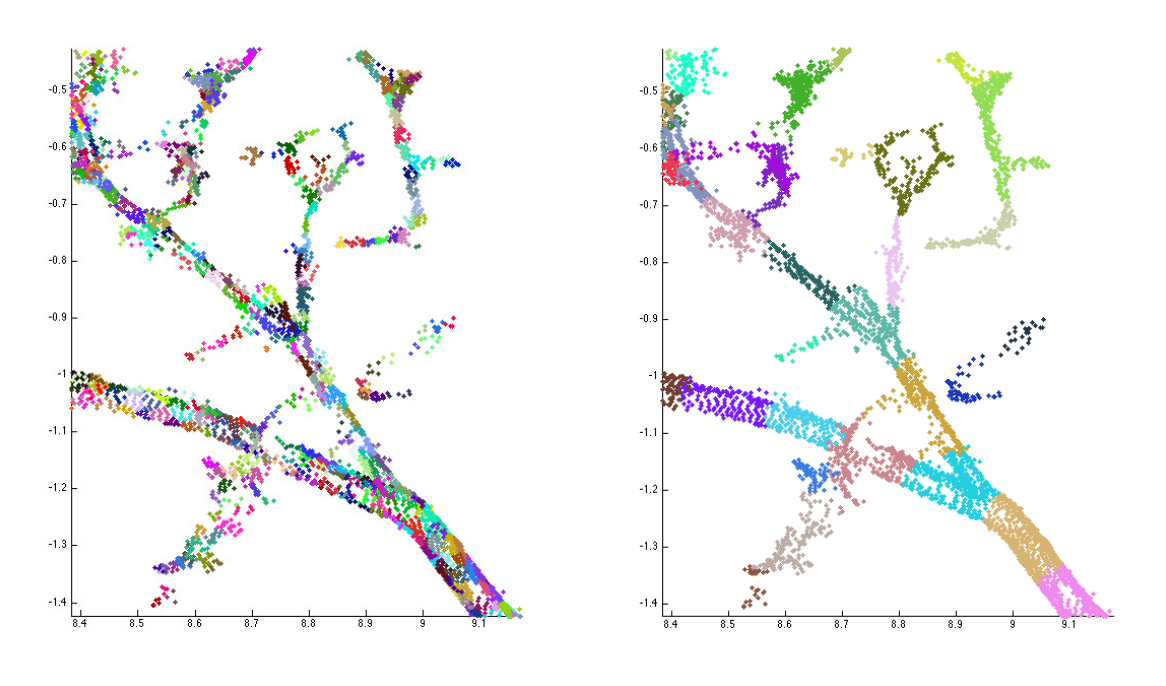
Figure 6. Comparison of the covers of a branch. The minimum diameters (d) of the cover sets are 2 cm ( left ) and 10 cm ( right ). The smaller cover sets can capture much more